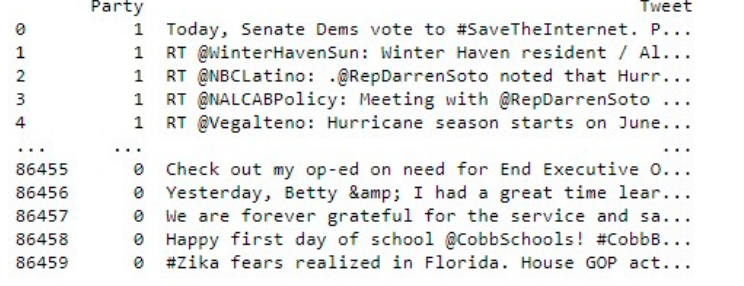
Figure 2. Input data divided into two columns (content, party) in the DataFrame